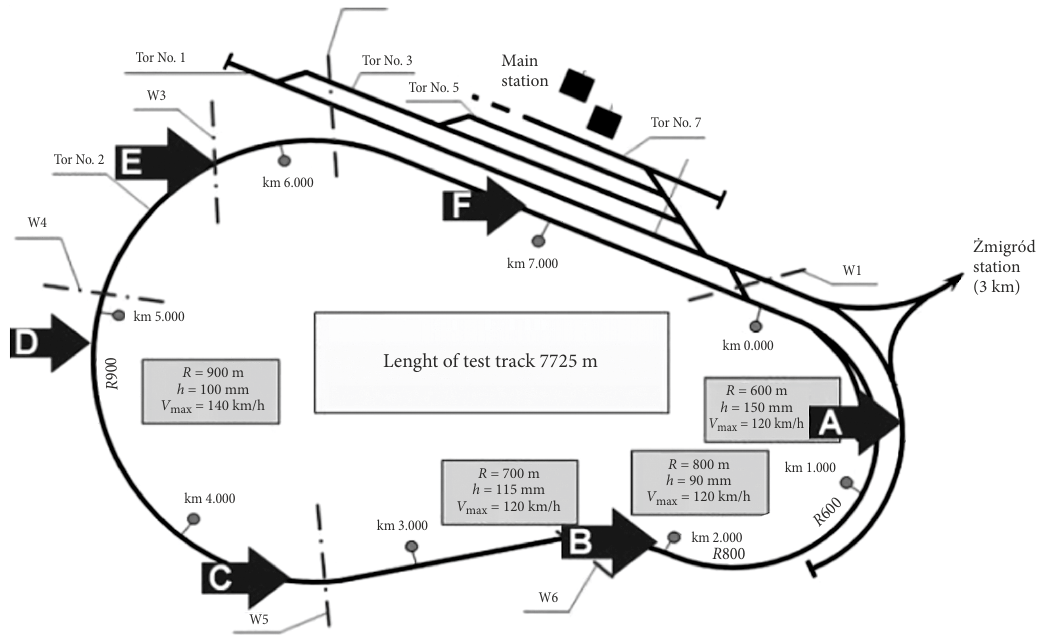
Fig. 6. Location points the start of measuring during preliminary tests at velocity v = 70